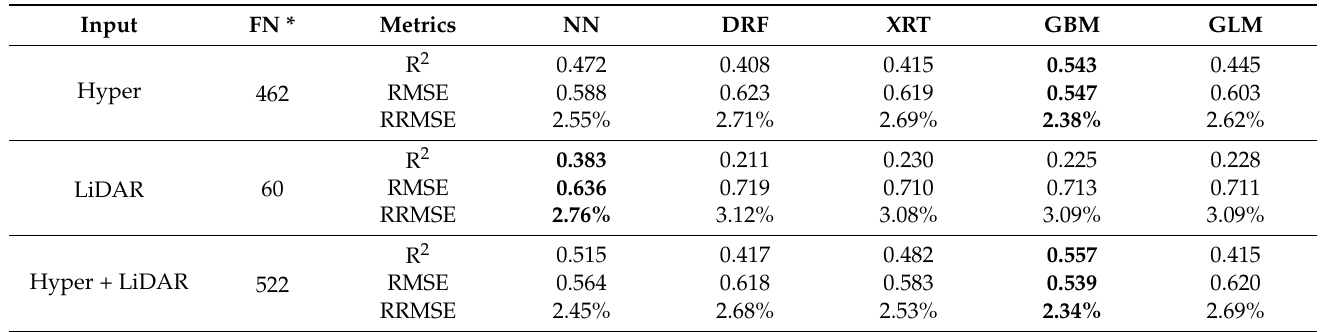
Table 7. Validation statistics of soybean oil concentration estimation using five/different AutoML methods. Best prediction results are highlighted in